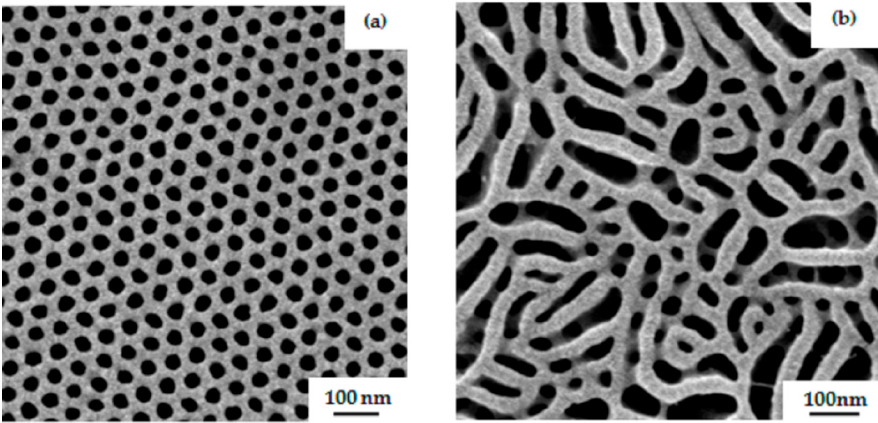
Figure 10. SEM images of surface of the membranes prepared from 22 wt % PS 81 -PGMA 19128 in THF/DMF/DOX (1/1/1); time of evaporation ( a ) 10 s ( b ) 20 s.